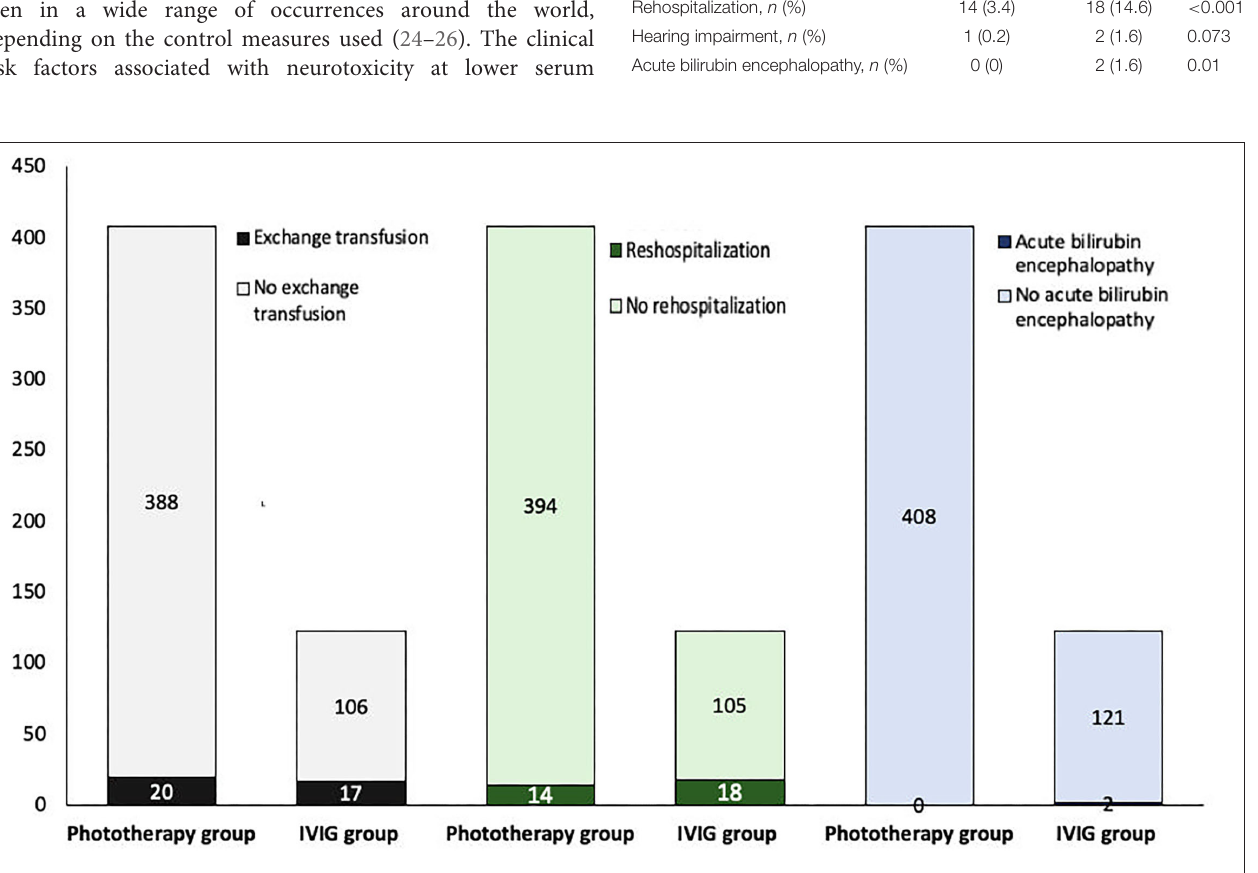
FIGURE 2 | Intravenous immunoglobulin (IVIG) has no advantage in avoiding exchange transfusion, rehospitalization, and neurological sequelae ( p = 0.001, < 0.001, and 0.01, respectively).